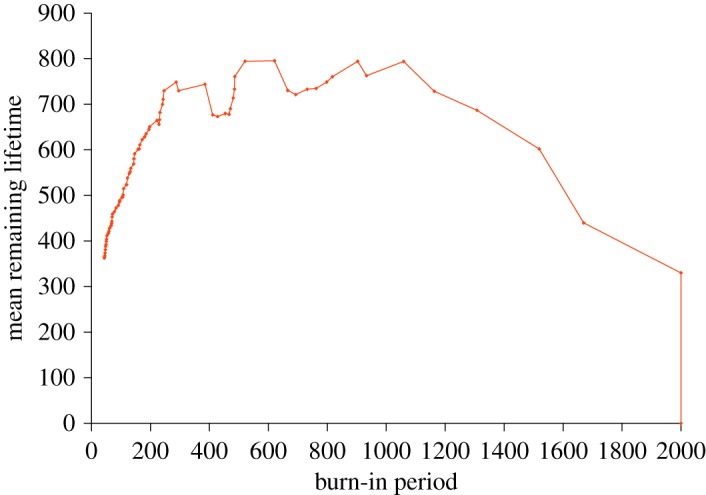
The MRL of a typical simulation of the Pomeau–Manneville map, with parameters as described in the text, grows rapidly.